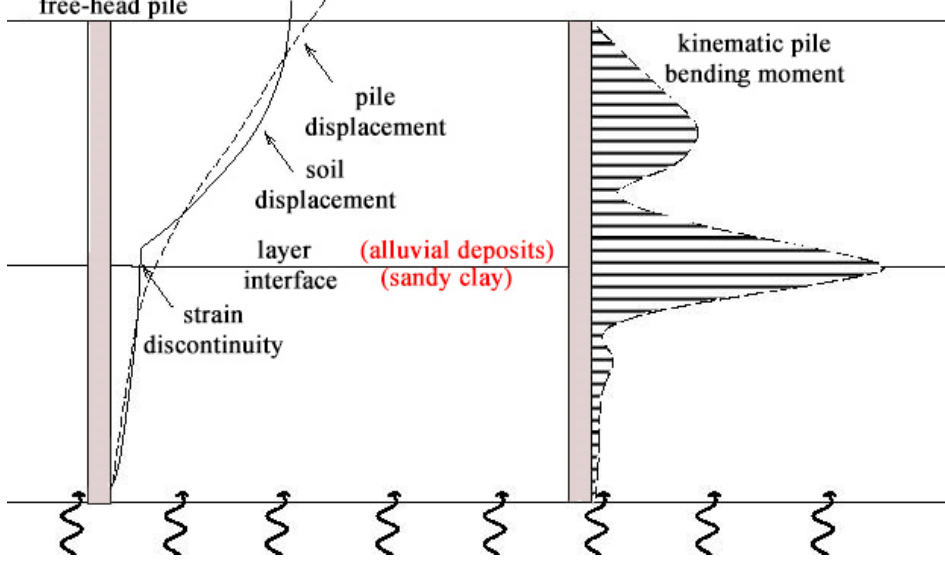
Figure 30. Peak bending moments along pile 4, using the 1693, 2012, and 1990 seismic inputs.